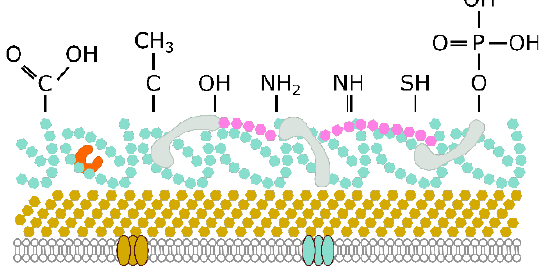
Figure 3. Functional groups and molecules responsible for metal sorption in fungi.